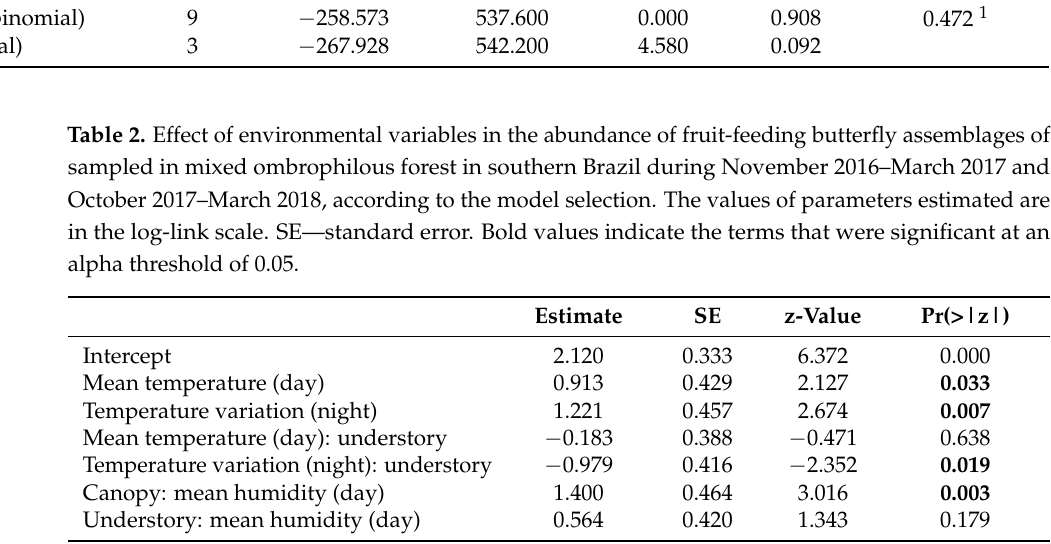
Table 1. Model selection table for models for richness and abundance of fruit-feeding butterfly assemblages sampled in mixed ombrophilous forest in southern Brazil during November 2016–March 2017 and October 2017–March 2018. In the null model, the response variables were modeled by 1, whereas, in the full model, they were modeled considering the environmental variables. We considered the best model to have the lowest AICc and a delta < 2. 1 Pseudo-R 2 calculated using the trigamma method and considering both fixed and random effects (conditional). df logLik AICc Delta Weight Pseudo-R 2 − 163.125